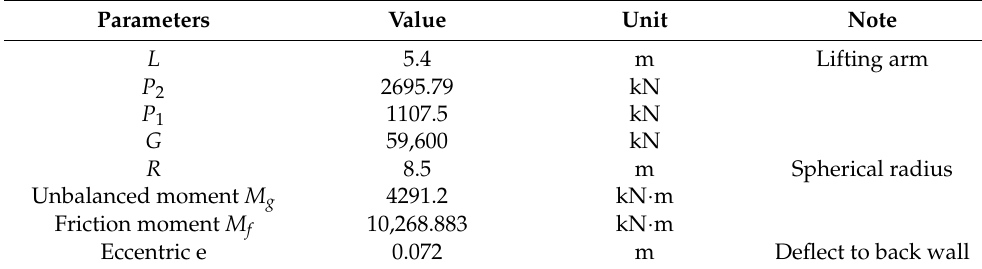
Table 2. Calculation results of the rotating system.